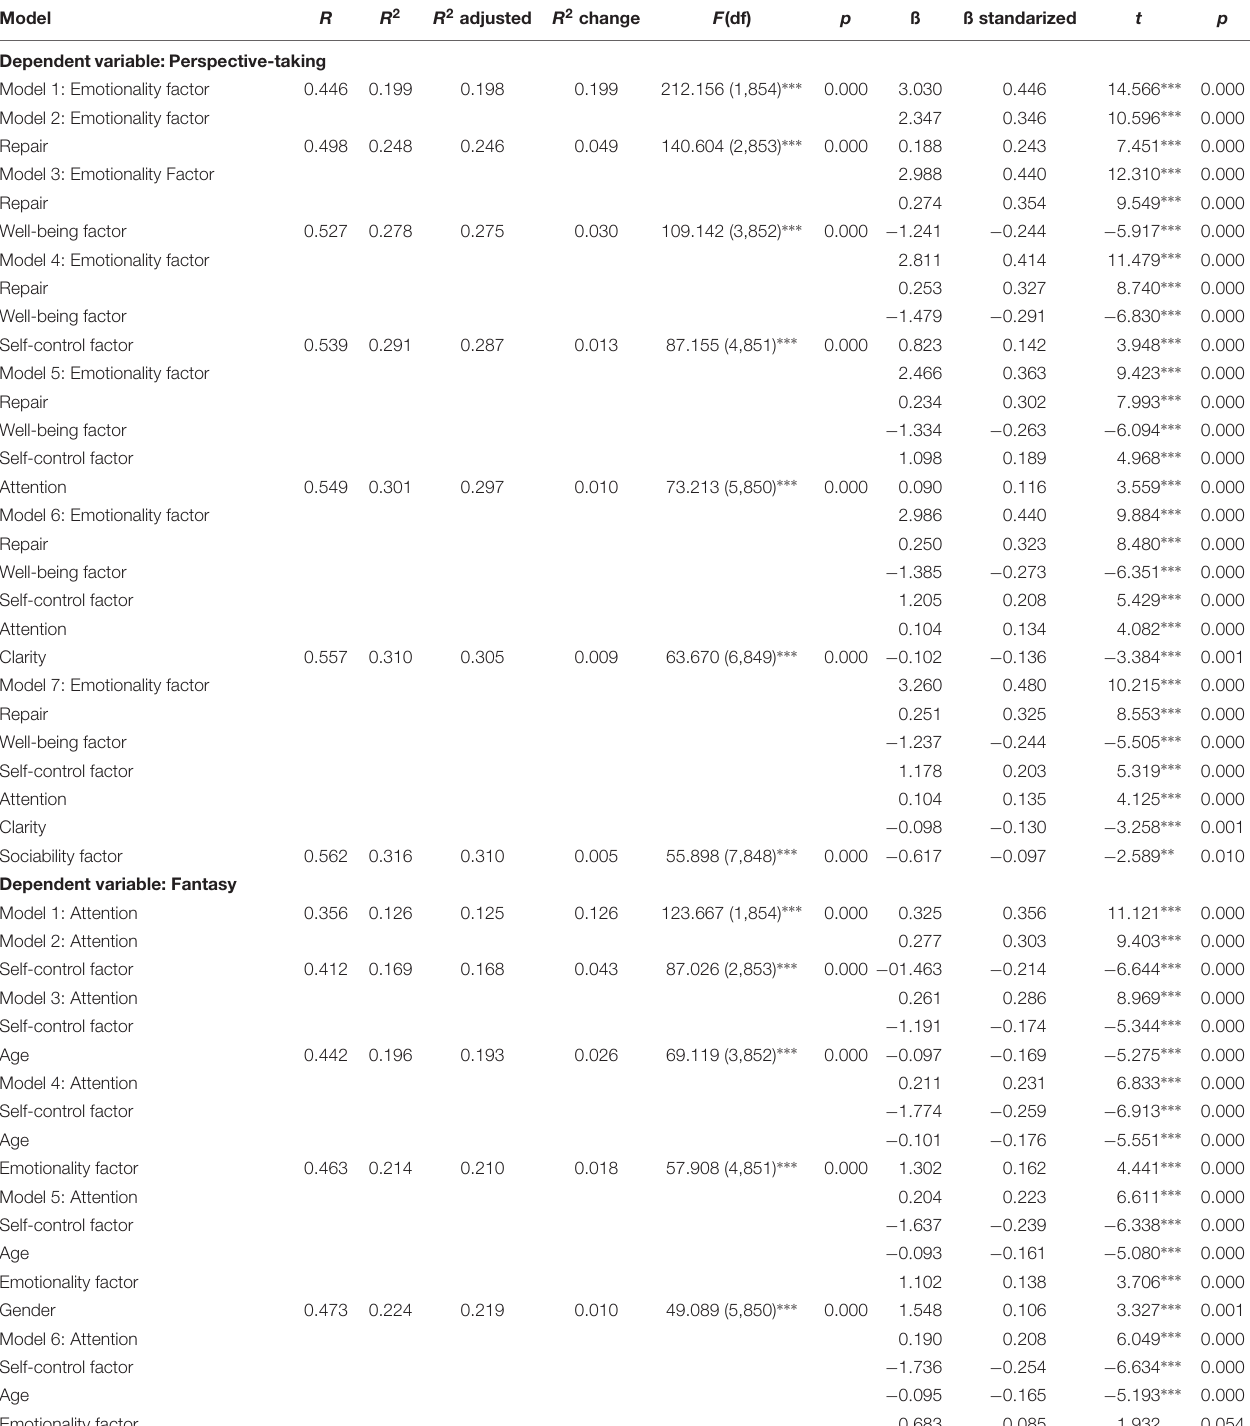
TABLE 3 | Stepwise multiple regression